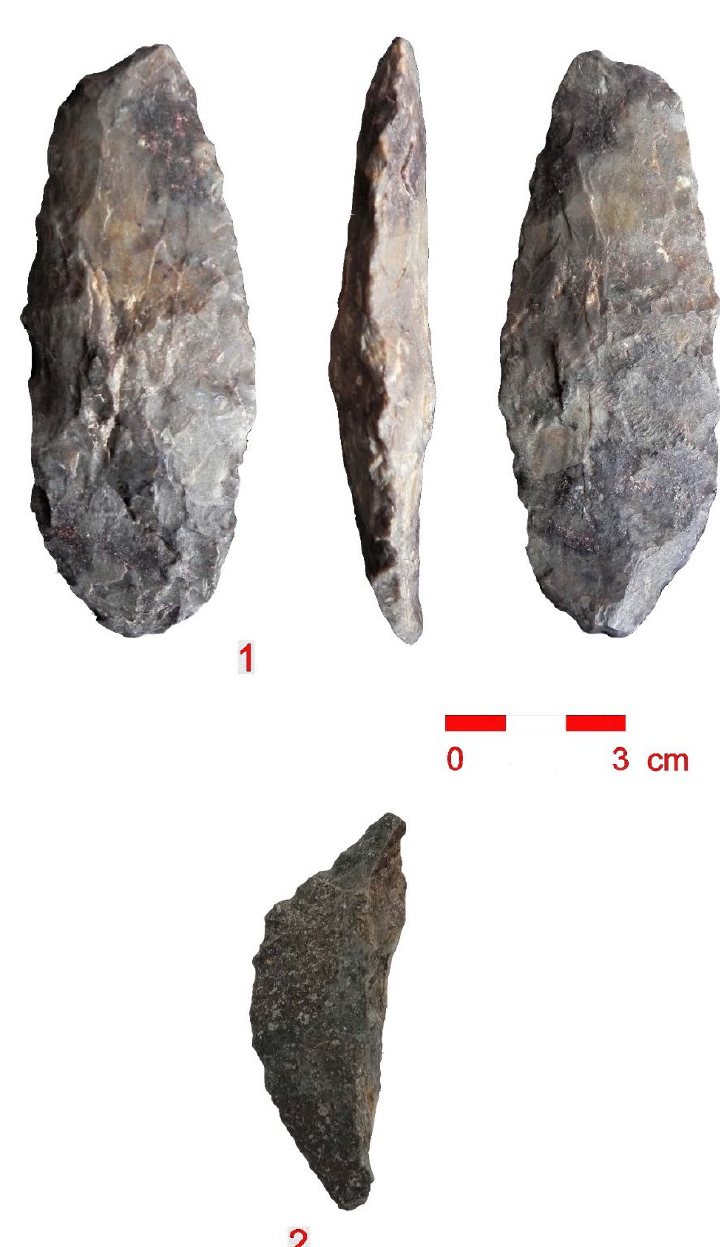
Figure 6. A bifacially flaked point (1) and a crescent-shaped backed piece (2). All artifacts made on